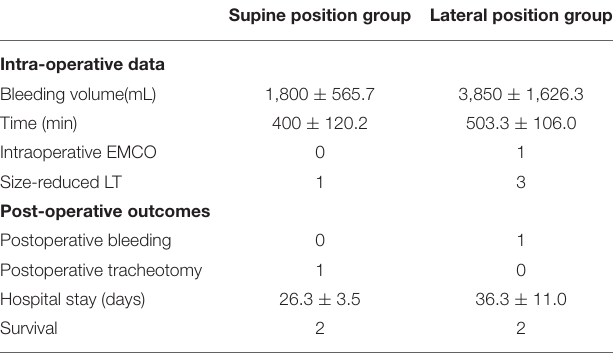
TABLE 2 | Comparisons of intraoperative and postoperative characteristics between supine position group and lateral position group.